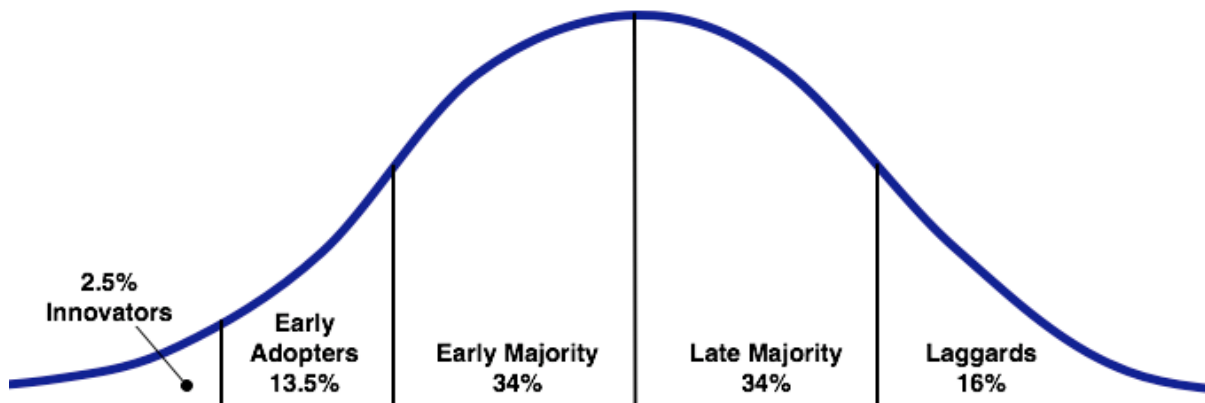
Figure 1. The ‘Diffusion of Innovations’ Model [18,19]. Adopter categorization on the basis of innovativeness. Source: Wikipedia, shared under the Creative Commons Attribution-Share Alike 2.5 License.